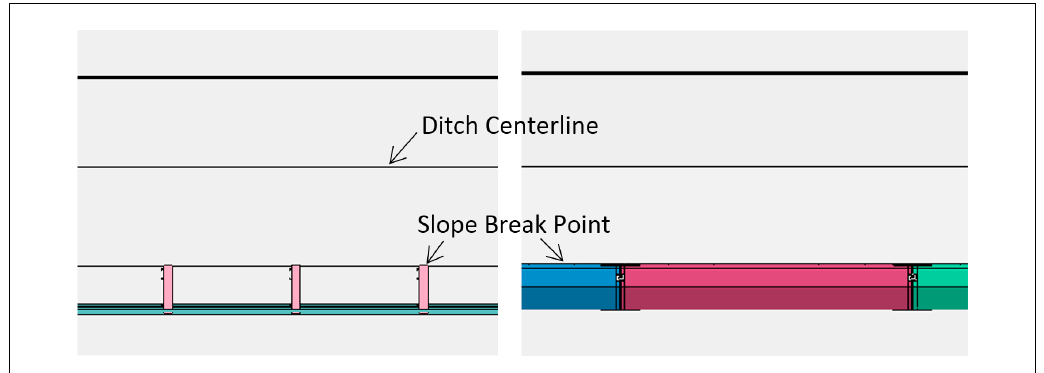
Figure 9. Finite element model of V-shaped ditch with both barrier models and the roadway (overhead view).